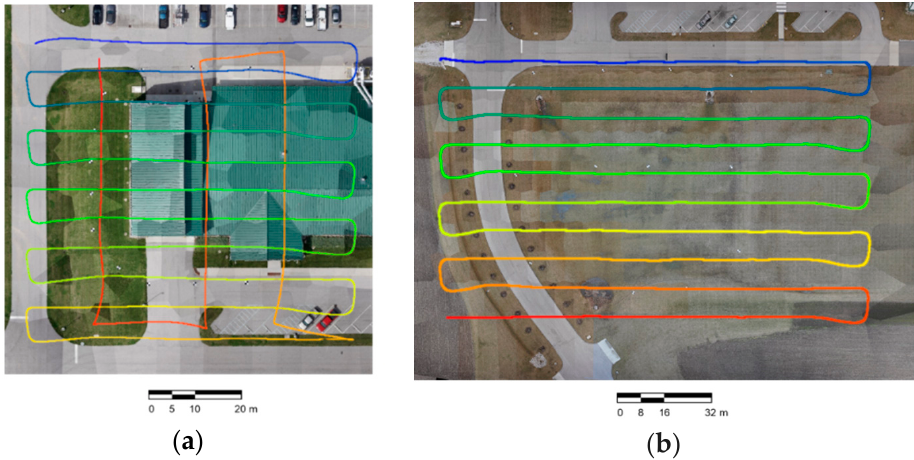
Figure 4. Top view of the flight trajectory (colored by time) superimposed on orthophotos of ( a ) Site I for the A-1 dataset and ( b ) Site II for the D dataset.